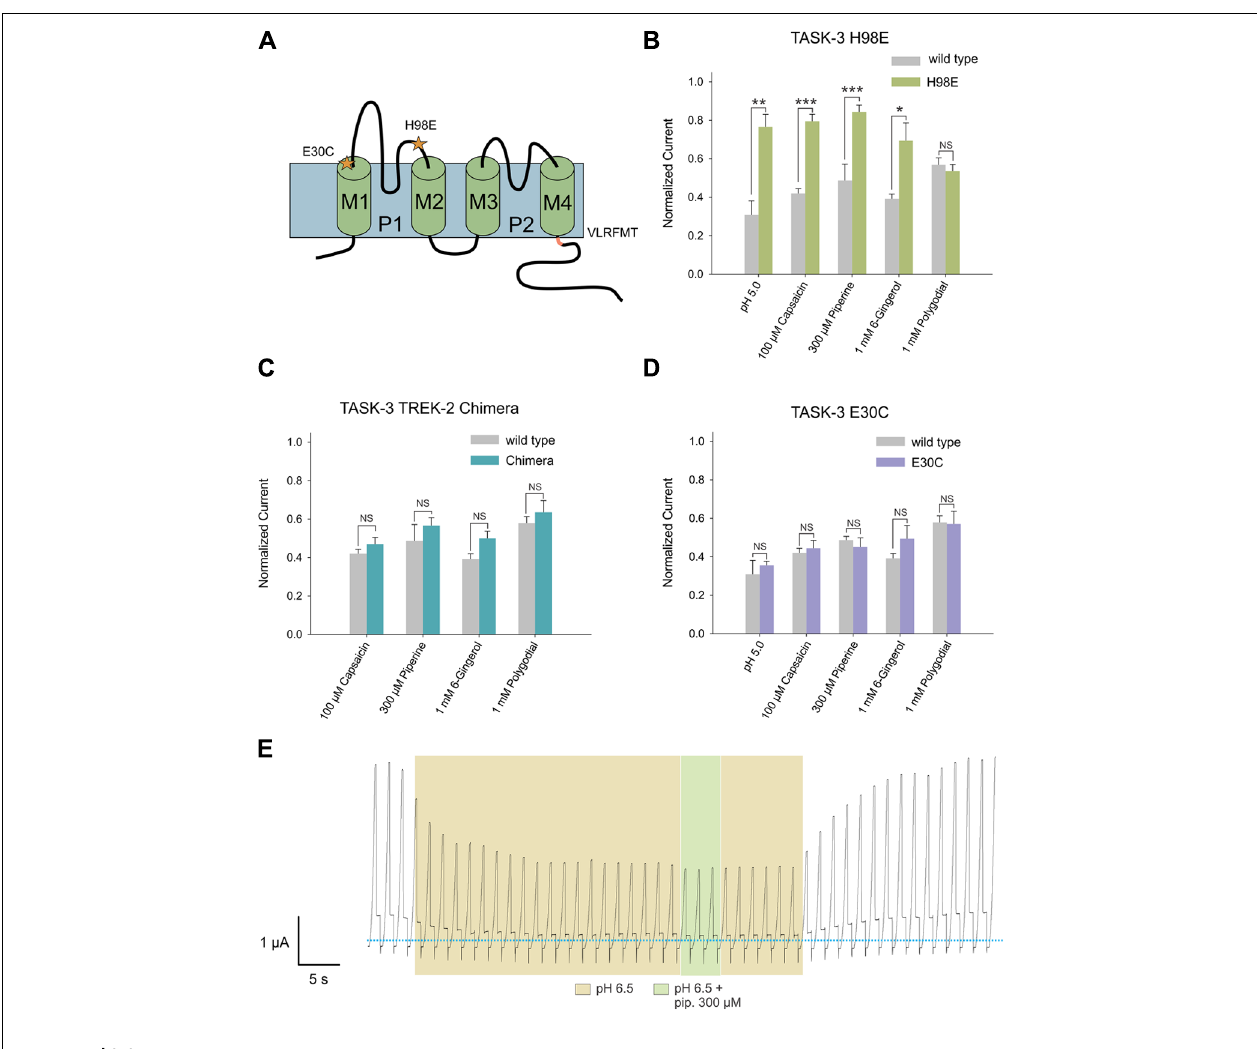
the four pungent substances under evaluation in wild-type hTASK-3 (gray bars) vs. TREK-2 chimera (light blue bars). N of 4-5 oocytes. (D) the E30C mutant (purple bars). N of 4–6 oocytes. ( E) Representative voltage clamp recordings of a Xenopus laevis oocyte expressing TASK-3 WT exposed to a pH of 6.5 and then to 300 μ M